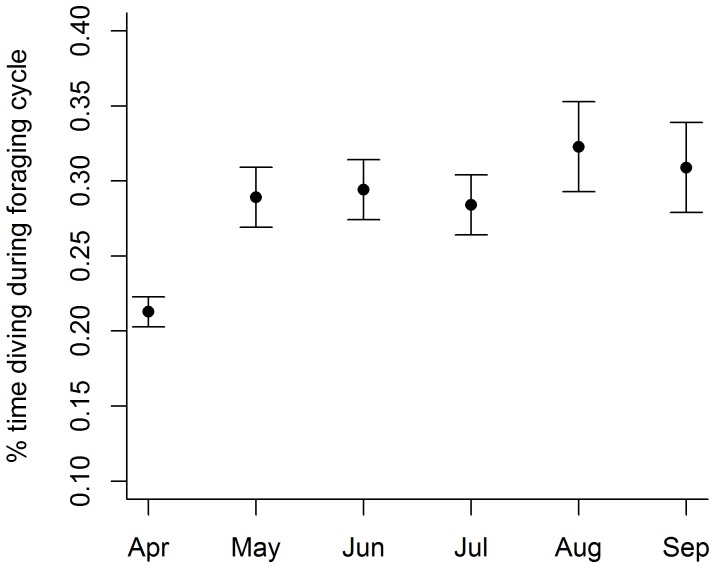
Seasonal effects on foraging effort within foraging cycle.Differences in the proportion of time spent diving during the whole foraging cycle (foraging trip duration+haul-out duration) throughout the second half of the lactation period for female Australian fur seals provisioning young at Kanowna Island, Bass Strait, Australia. (values taken from the coefficient estimates and corresponding standard errors of the LME model. see Table 3 for statistical results).